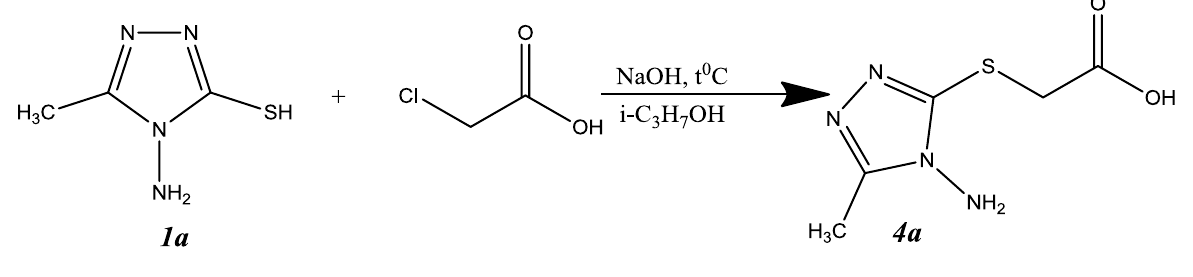
Fig. 2. Scheme of synthesis of 2-((4- (amino) -5-methyl-4H-1,2,4-triazol-3-yl) thio) acetic acid ( 4a )